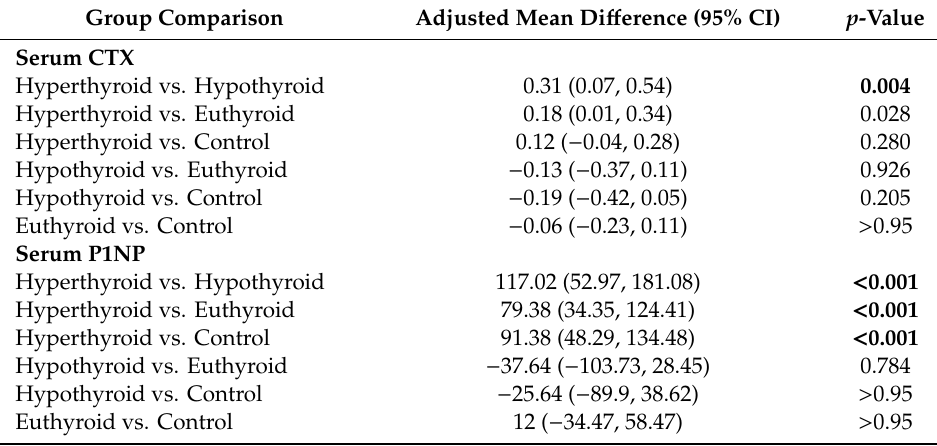
Table 11. Post hoc pairwise comparison between mean of bone turnover markers adjusted for age and gender in between groups